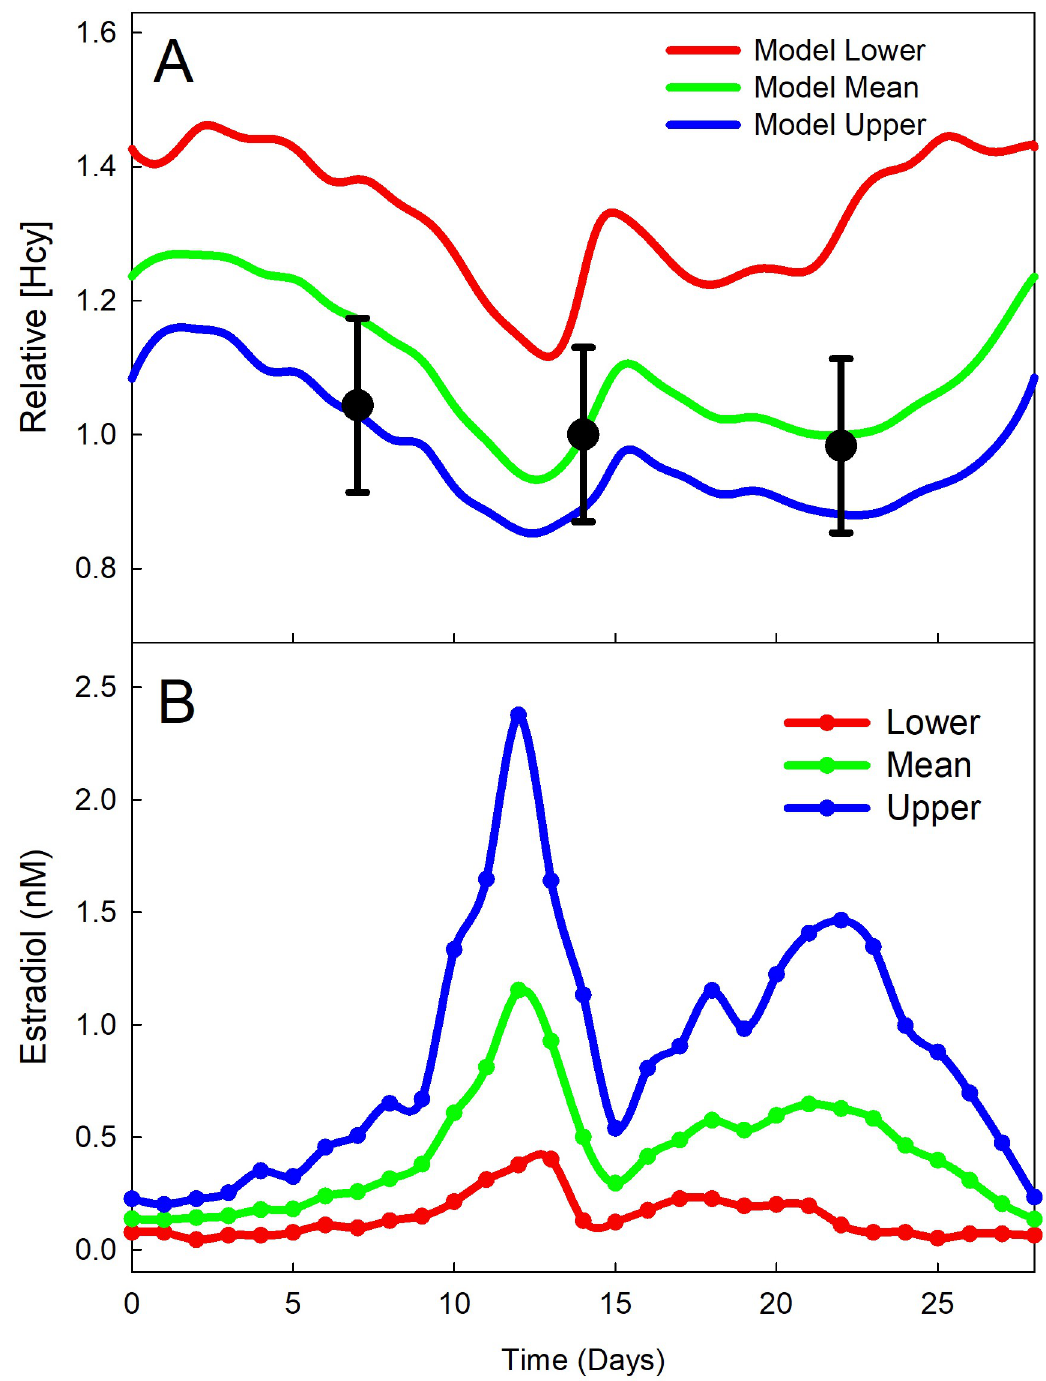
Fig 2. Hcy and E2 throughout the menstrual cycle. Model predictions of relative Hcy variation using three different estradiol curves are plotted. (Panel A). The Hcy experimental data and the Hcy model curves are plotted relative to the Hcy concentration on day 14 (predicted ovulation) of the mean estradiol curve. The Hcy data [44] is plotted with error bars representing the standard deviation. The model estradiol curves were determined by interpolation of data from [7, 42, 43]. The data is regraphed in Panel B, where the three curves are mean estradiol (Mean), the 95th percentile (Upper), and the 5th percentile (Lower). The errors bars are standard deviation. The corresponding model Hcy curve for each estradiol curve is plotted in Panel A in the same color with the same